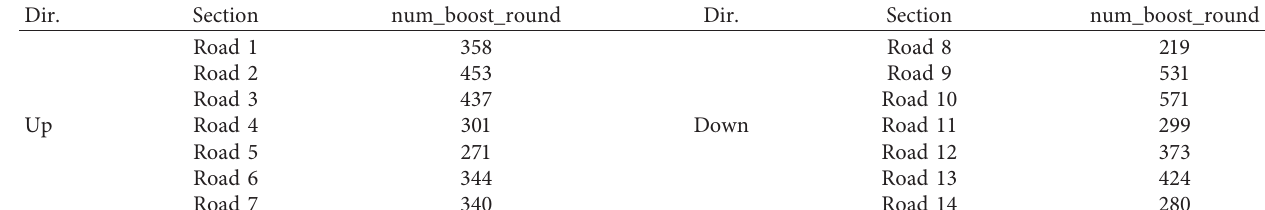
Figure 5: Num_boost_round and learning_rates up-direction and down-direction parameters’ adjustment results. Table 1: num_boost_round results of 14 roads.